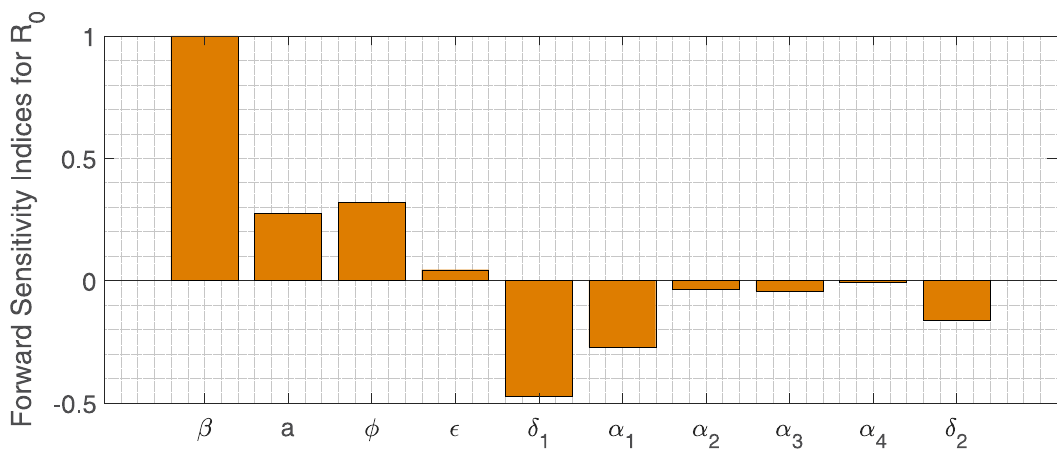
Fig 7. Normalized forward sensitivity indices of R 0 .